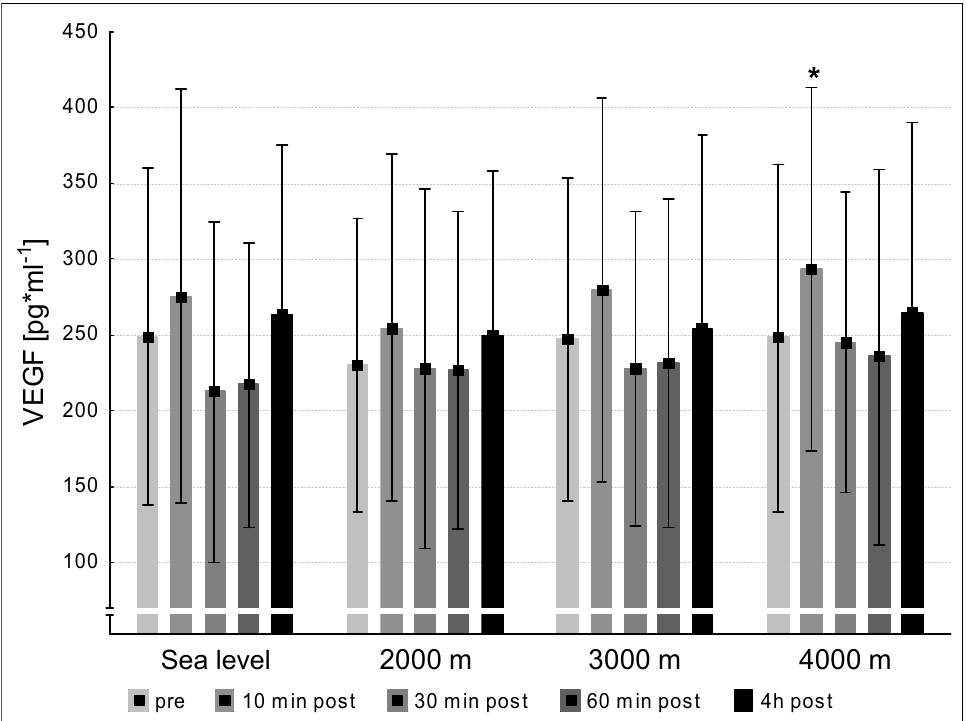
Figure 2. VEGF (vascular endothelial growth factor) concentration at the five measurement time points (pre, 10 min post, 30 min post, 60 min post, 240 min post exercise) during the different ambient conditions (sea level, 2000 m, 3000 m, 4000 m). Mean ± standard deviation. * = p < 0.05 to pre.